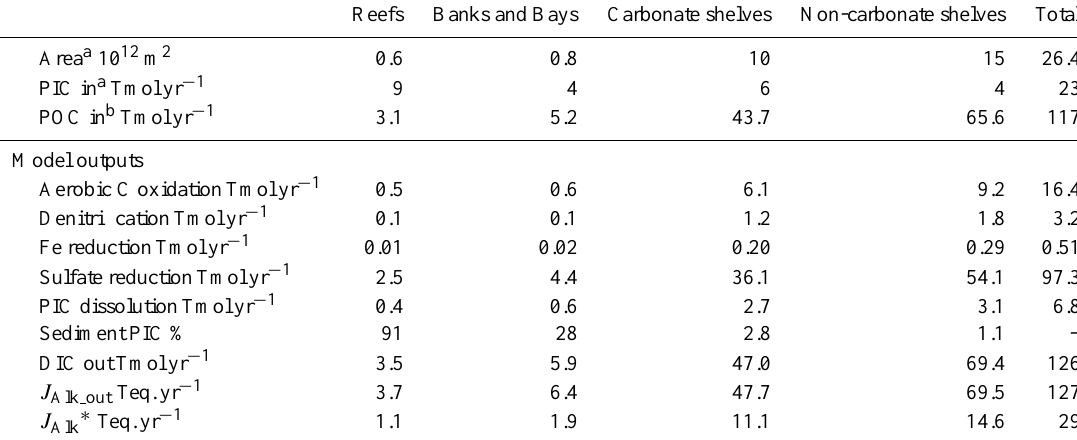
Table 7 . Benthic C and alkalinity fluxes by environment, baseline case. Reefs Banks and Bays Carbonate